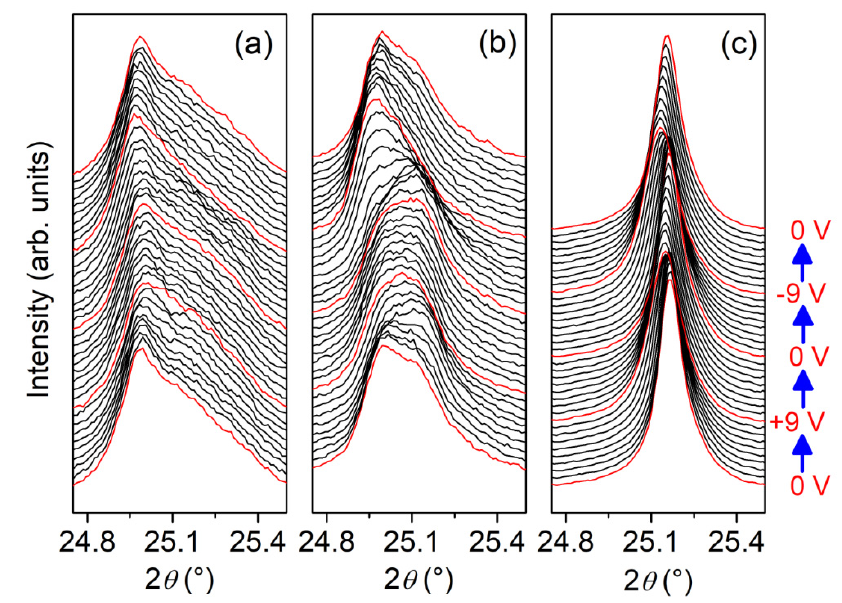
Figure 3. Profiles of the PLZT 110 Bragg peak for ( a ) PLZT0, ( b ) PLZT3 and ( c ) PLZT12 thin film. The profiles for different applied voltages, ranging from − 9 V to +9 V, are shifted vertically for clarity. One can note the presence of double peak features for the PLZT0 and PLZT3 samples, and a simple Bragg peak for the PLZT12 thin film.